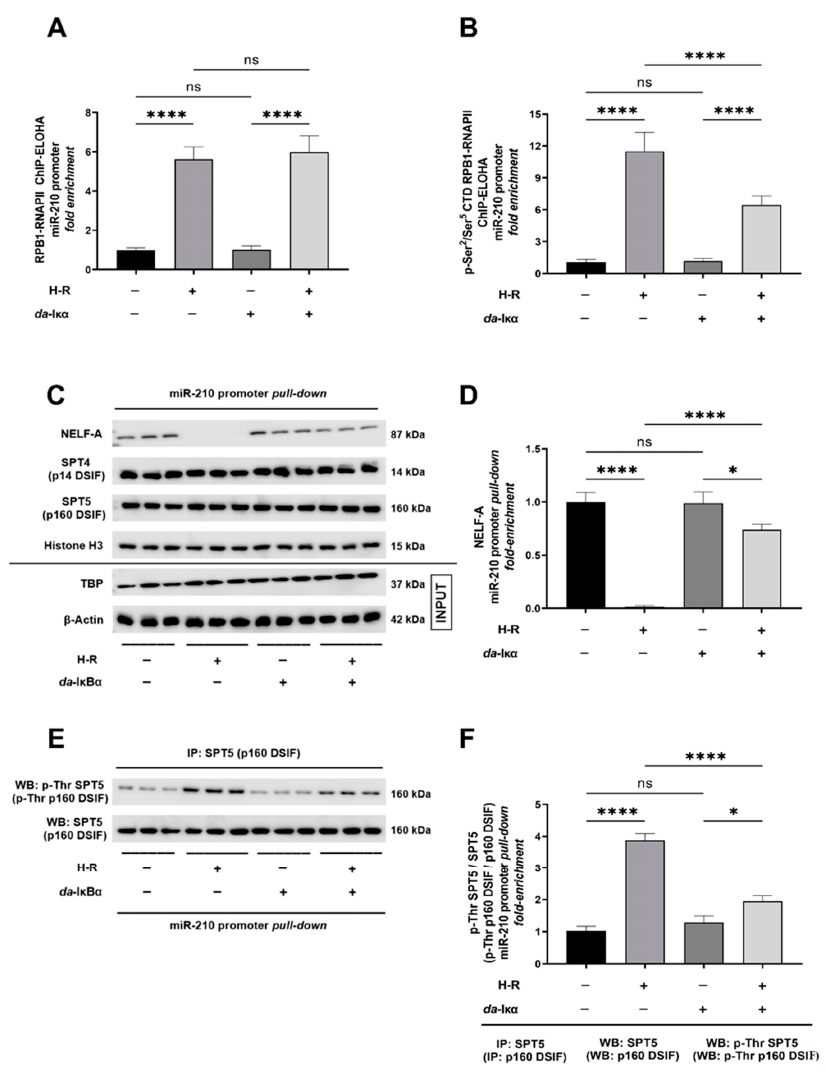
Figure 4. NF- κ B activation significantly mediates the hypoxia–reoxygenation (H-R) challenge-induced increase in the recruitment and occupancy of active RNA polymerase II (RNAPII) at the miR-210